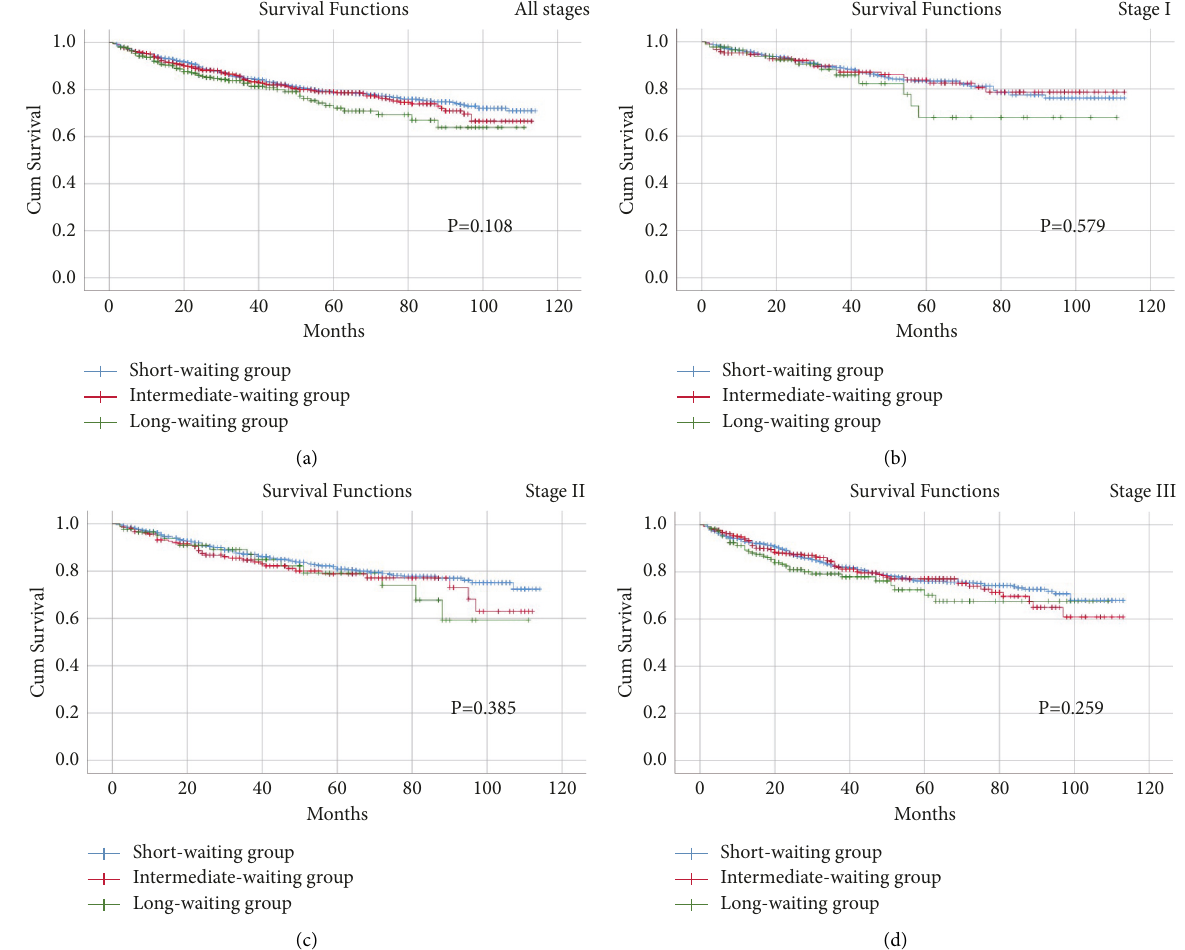
Figure 3: Disease-free survival among three groups, including short-waiting group, intermediate-waiting group, and long-waiting group. (a) stage I; (b) stage II; (c) stage III; (d) stage